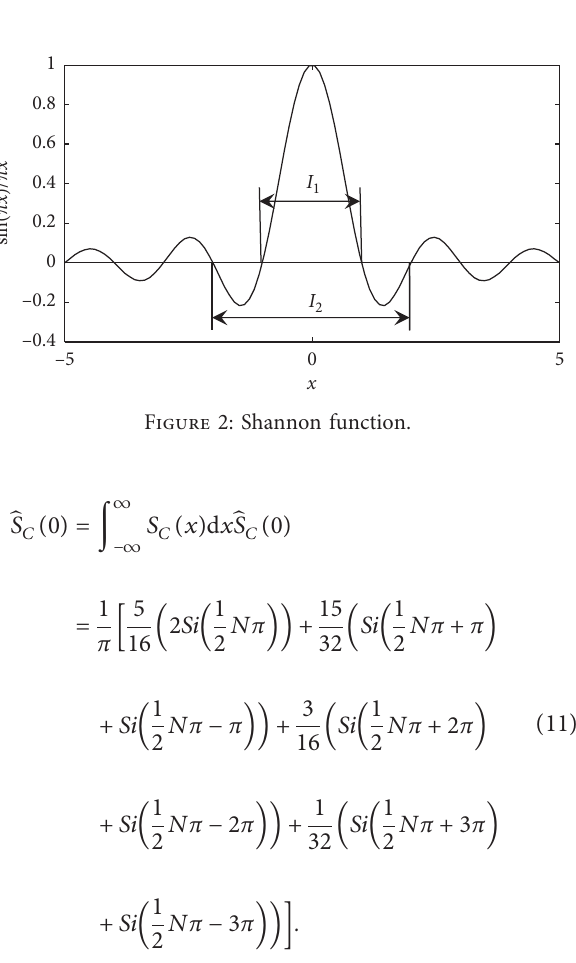
Figure 1: Comparison between Shannon and Shannon-Cosine scaling functions. (a) Shannon function. (b) Shannon-Cosine scaling function.